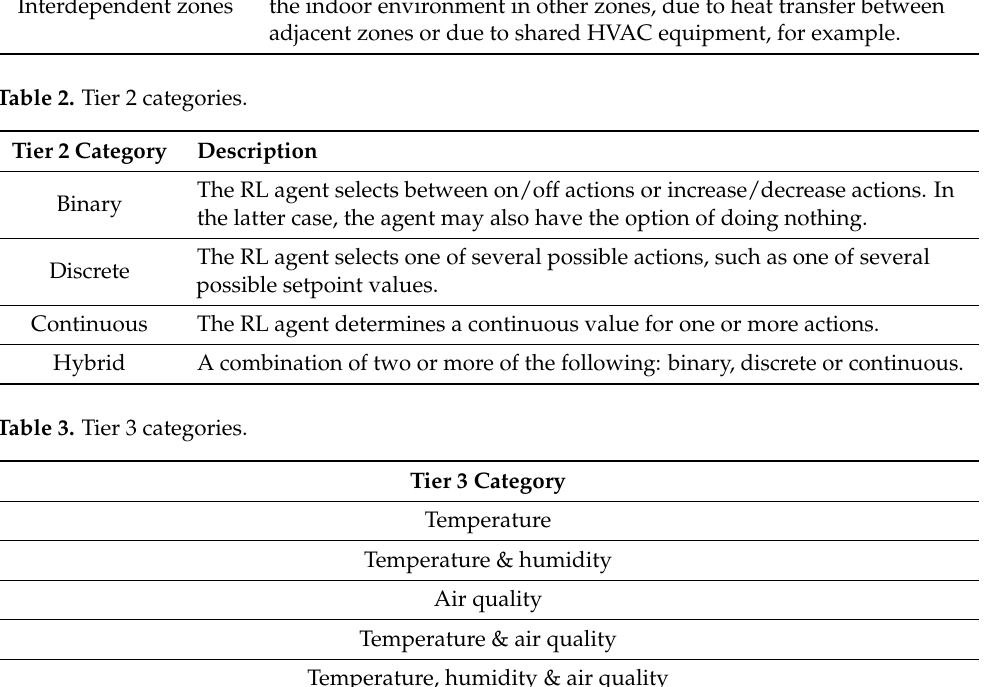
Table 1. Tier 1 categories.